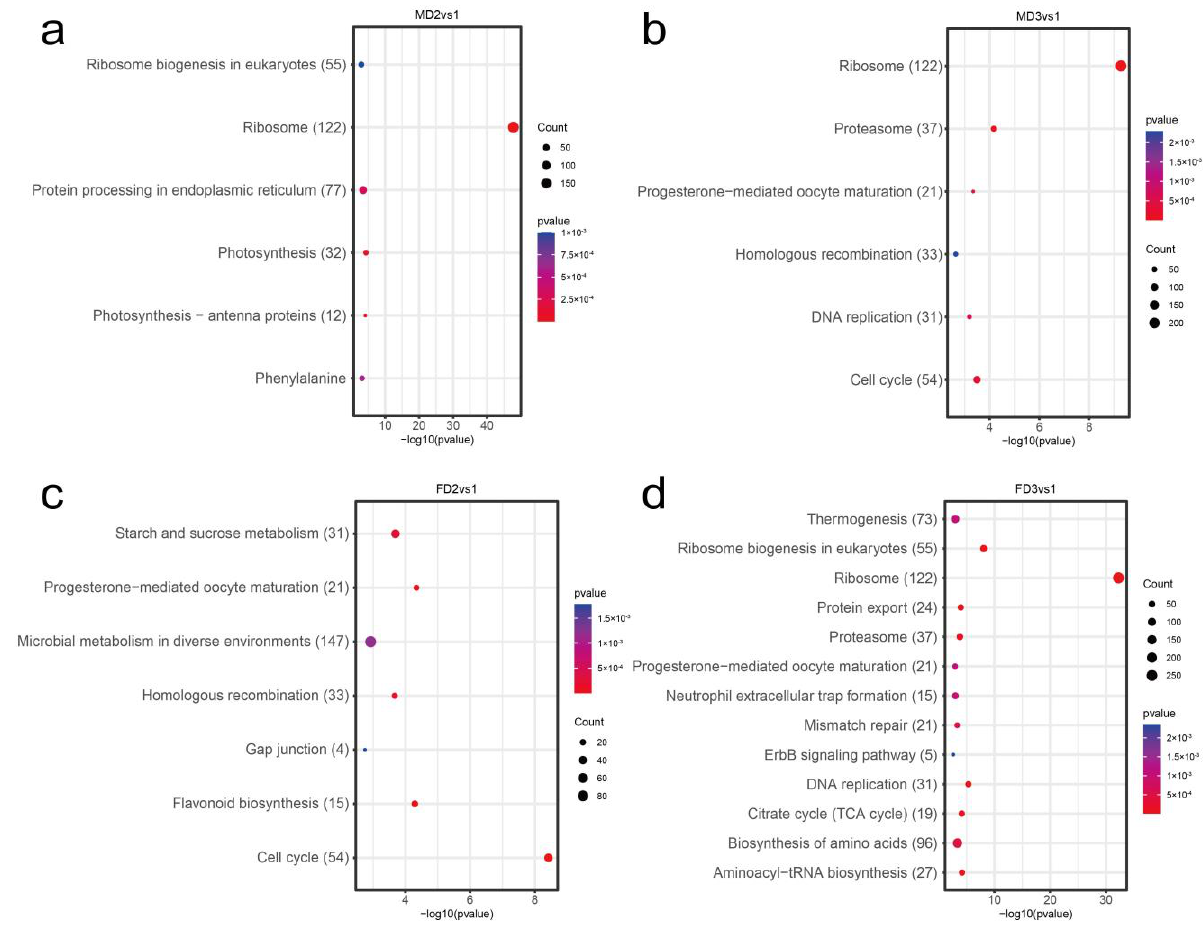
Figure 10. KEGG pathway analysis of male and female flower buds. The upper row shows enriched pathways for DGEs in male flower buds at the formation of the ( a ) flower primordial (MD2) and ( b ) stamen primordia (MD3) stages. The lower row indicates enriched pathways for female flower buds at the formation of the ( c ) flower primordial (FD2) and ( d ) pistil primordia (FD3). The enriched KEGG pathways and the uniqueness of enriched factors are shown on the vertical and horizontal